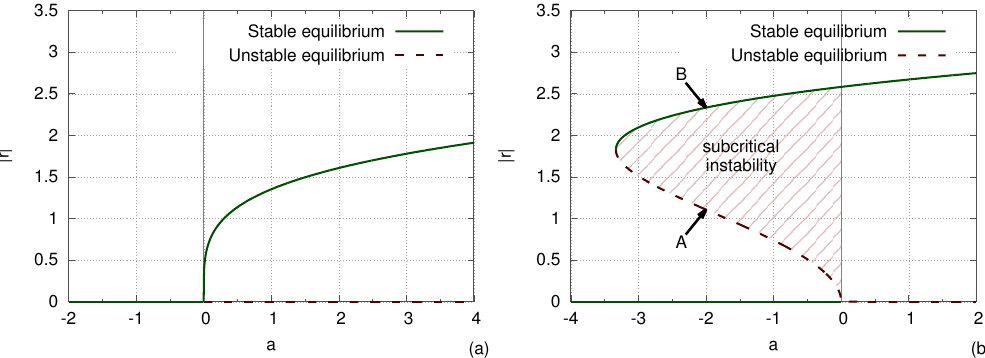
Figure 3. Bifurcation diagram, which yields the nonlinear stability. The solid curves are the stable equilibria | r | = 0 and | r | = r max , which correspond to the saturation amplitude. The dashed curves are the unstable equilibria | r | = 0 and | r | = r min , which correspond to the threshold amplitude. ( a ) Supercritical system: b = 0. ( b ) Subcritical system: b = 1. The region of subcritical instability is shown by hashes. The same points (A and B) as in Figure 2 are shown by arrows in this figure as